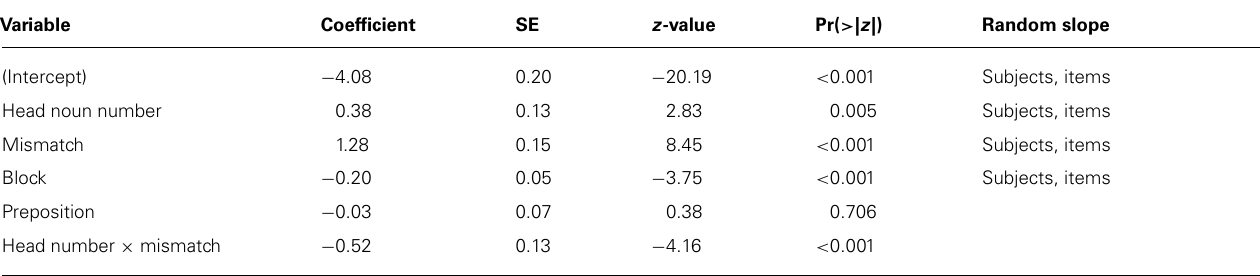
Table 3 | Logistic mixed-effects model predicting agreement errors in Experiment